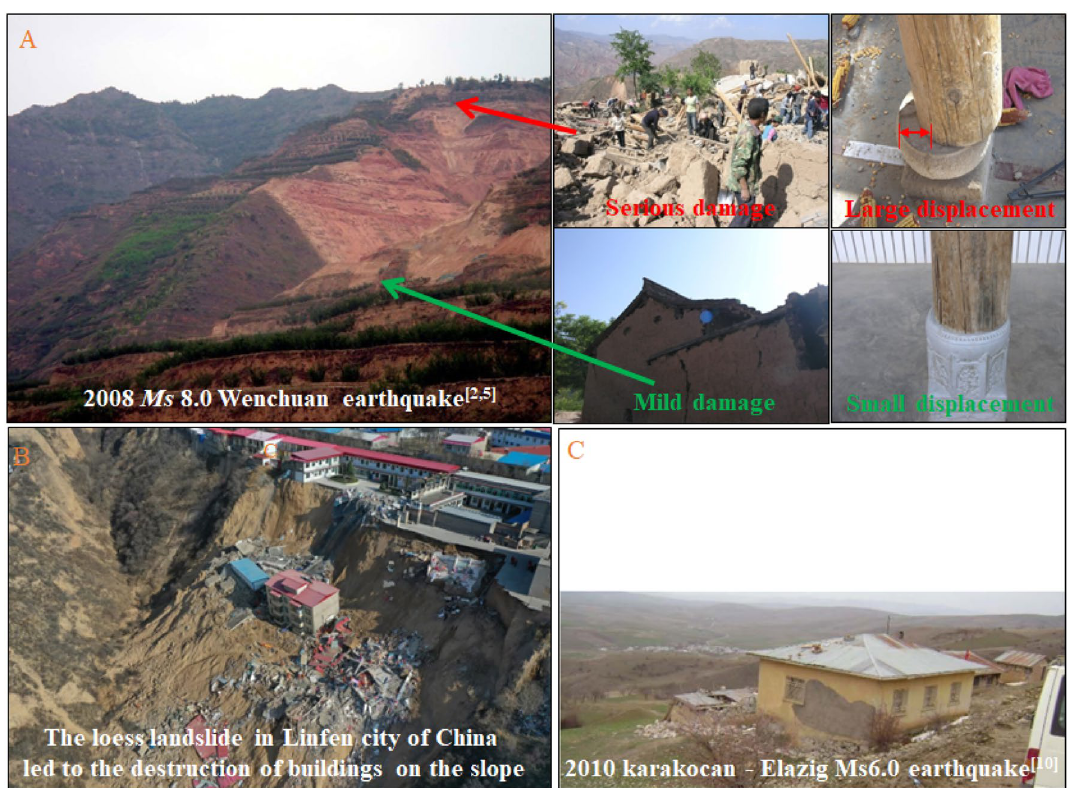
Figure 1. Examples of building failure on top of slope caused by landslide 2,5,10